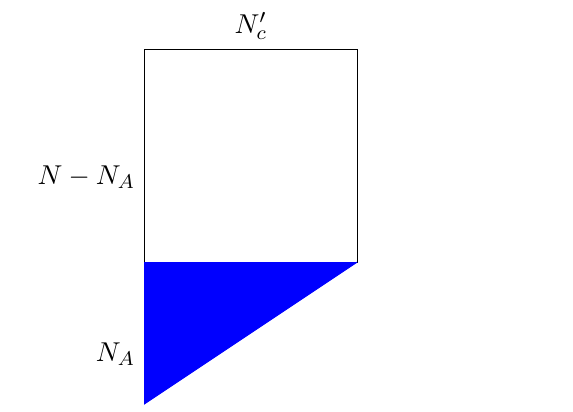
giant gravitons, c excitation. c